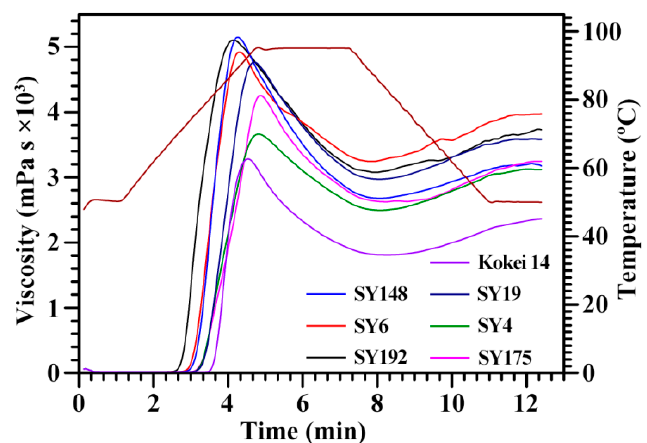
Figure 4. RVA profiles of C-type starches from different sweet potato varieties. Table 6. Pasting property parameters of C-type starches from different sweet potato varieties.